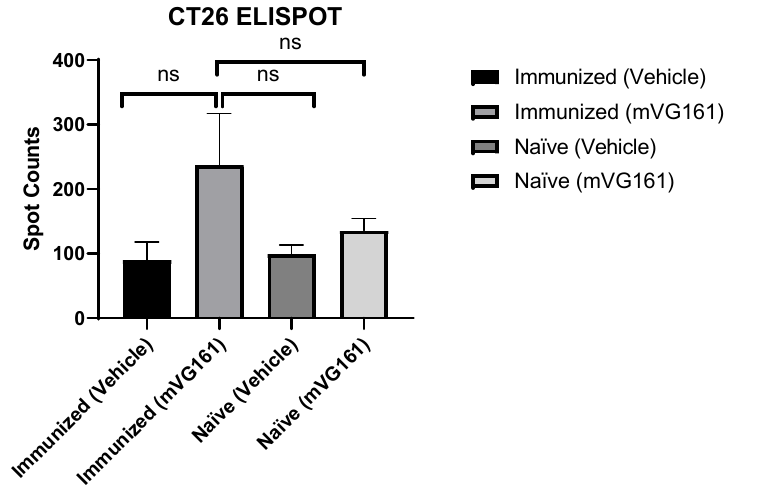
Figure 4. CT26 Balb/c mouse models. Splenocytes were collected from each mouse 10 days after administering mVG161 or vehicle control. Cells were co-incubated with CT26 cells. ELISPOT kit was used to detect IFN- γ expression. Data points represent number of spots for each mouse. Error bars represent standard error of the mean (SEM).